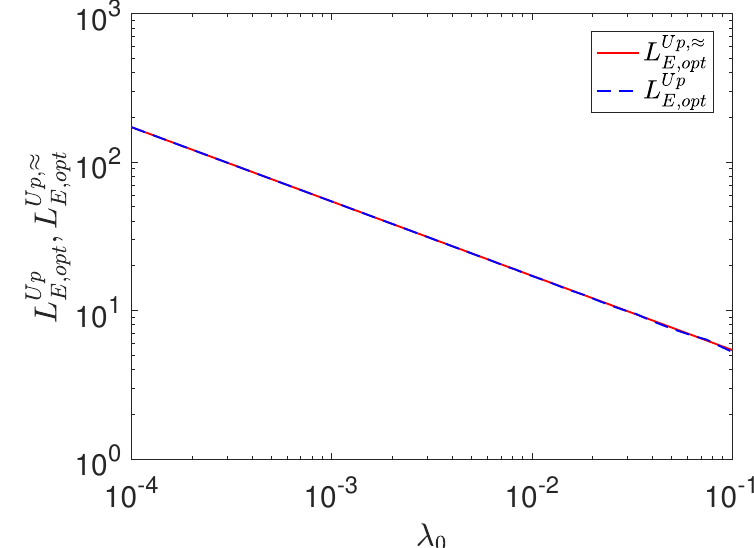
( λ ) and its 0 E , opt ∈ (cid:2) 10 − 4 ,10 − 1 (cid:3) of the fraction of 0 ( λ ) and L Up , ≈ ( λ ) , 0 0 E , opt E , opt